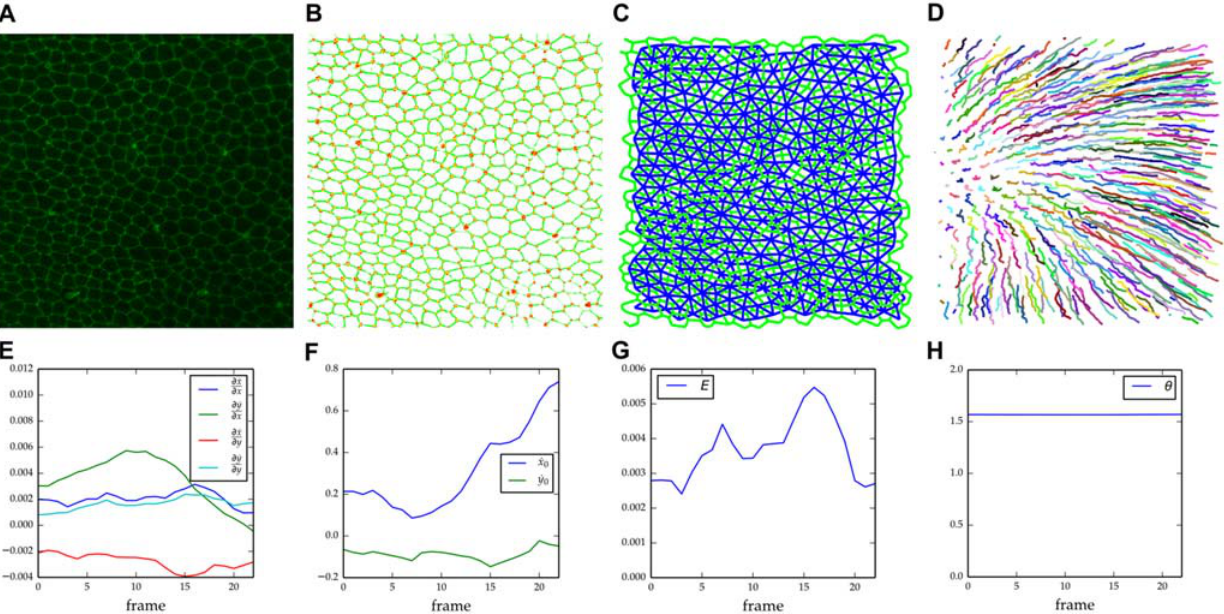
Fig 3. Analysis of Drosophila notum morphogenesis. A) A Maximum intensity projection of an image stack through the mid-scutum marked with E- cad :: GFP to highlight cell outlines. Anterior to the right. B) Maximum intensity projection of the output of the filters employed to detect the AJs (green) and AJ vertices (red). C) AJ graph (green) and Cell graph (blue) symbolically represent the cell outlines and their connectivity, respectively. D) Projection of the 3D centroid trajectories recovered after tracking the motion of cells. Note that motion of cell centroid varies depending on the position of the cell across the , @ _ x , @ _ y , @ _ y ) computed from Kalman smoothed trajectories of cell centroids over time. F) Mean velocities tissue. E) Evolution of cell strain rate parameters ( @ _ x @ x @ y @ x @ y ( _ x 0 , _ y 0 ) of the cell centroid trajectories over time. Time evolution of G) expansion coefficient E , and H) rotation coefficient θ . See text for further